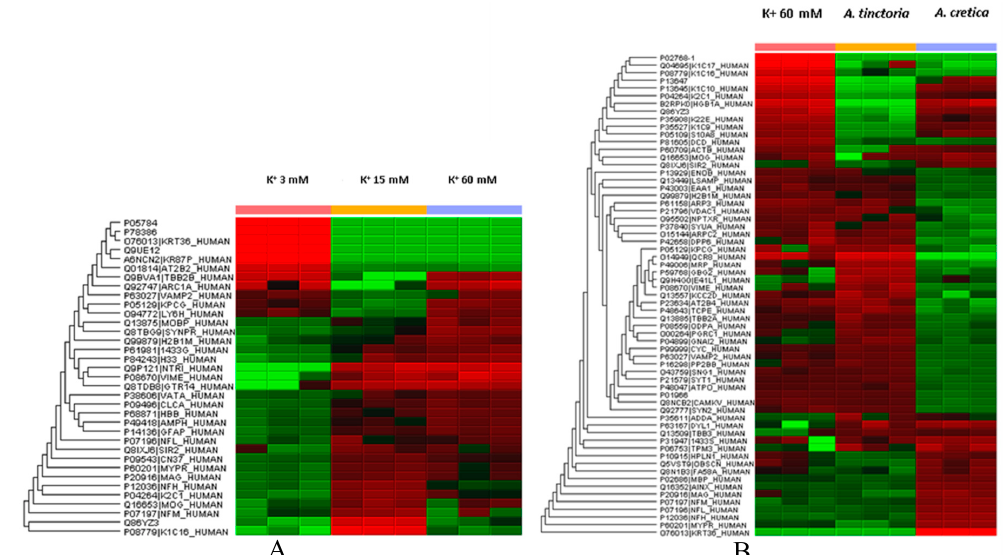
A B Figure 7. Panel A : Untargeted proteomic analysis performed on rat cortex challenged with basal (K + 3mM) and depolarizing stimuli (K + 15 mM; K + 60 mM). The activity of the detected proteins was calculated in comparison with the calibrator of the experiment (K + 60 mM). Panel B : Untargeted proteomic analysis showing the e ff ects of A. tinctoria and A. cretica water extracts (100 µ g / mL) on rat cortex challenged with excitotoxicity depolarizing stimulus (K + 60 mM). The activity of the detected proteins was calculated in comparison with the calibrator of the experiment (K + 60 mM). In subfigure A , it is showed that K + 60 mM depolarizing stimulus downregulated NEFMs and upregulated VAMP-2 and PKC γ levels. On the other hand, as depicted in subfigure B , A. cretica water extract (100 µ g / mL)